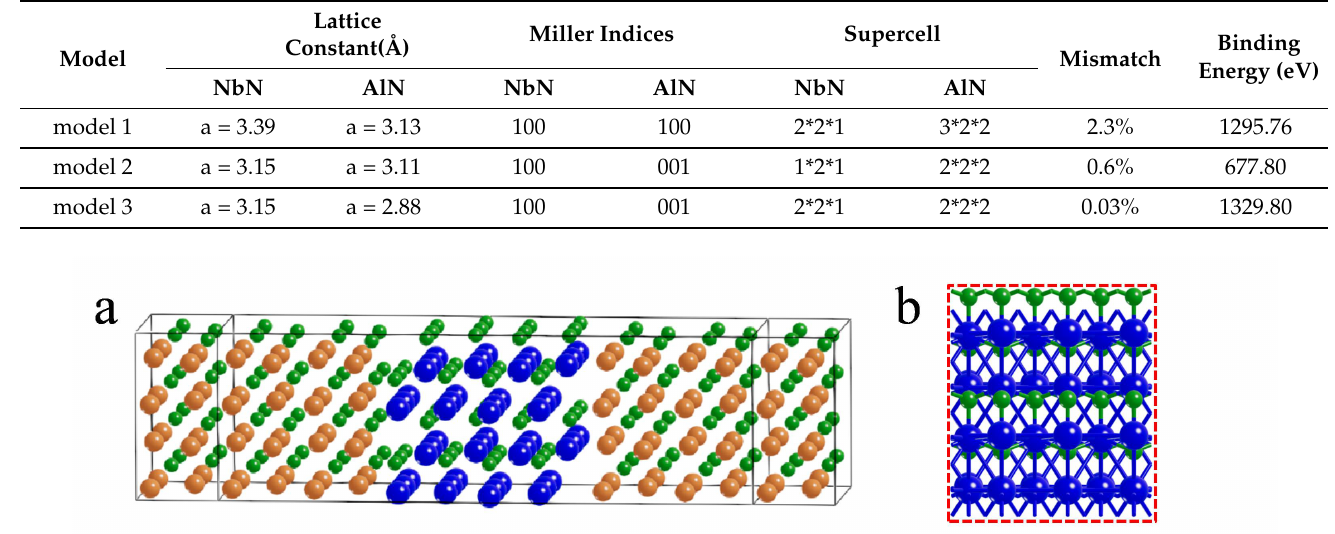
Table A1. Parameters of the defect-free models.